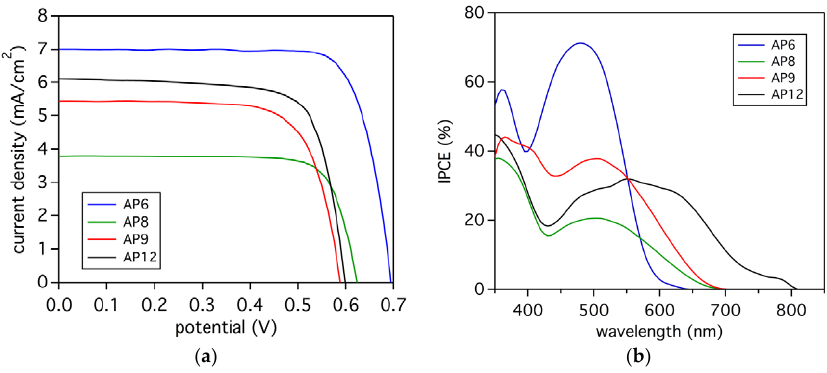
Figure 5. ( a ) J – V curves for DSC devices with AP6 , AP8 , AP9 , and AP12 . ( b ) IPCE curves for AP6 , AP8 , AP9 , and AP12 ‐ based DSC devices.